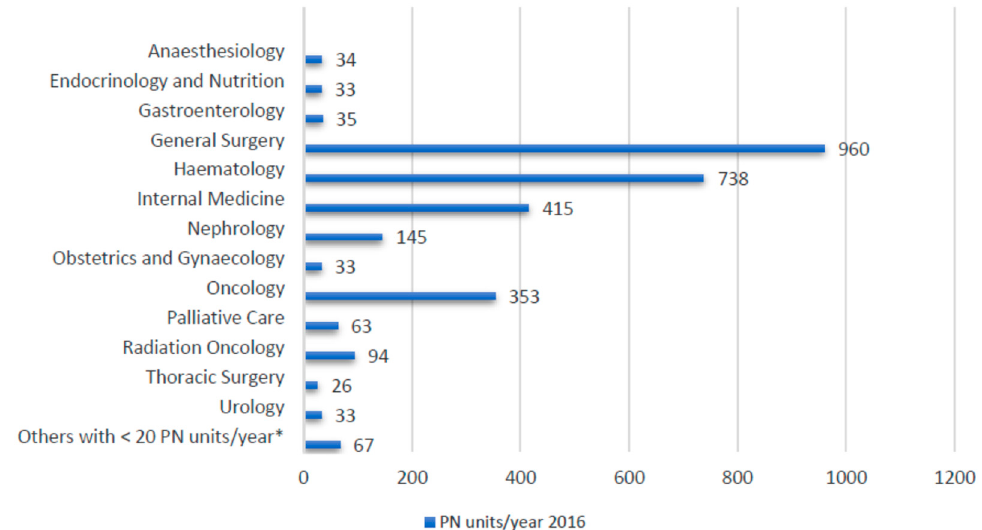
Figure 1. Distribution according to the clinical requesting service. * Others with <20 PN units/year include Cardiac Surgery (9), Cardiology (19), Pneumology (9), Neurology (4), Oral and Maxillofacial Surgery (11), Orthopaedic Surgery (9), Plastic Surgery (3) and Vascular Surgery (3). PN: Parenteral Nutrition.